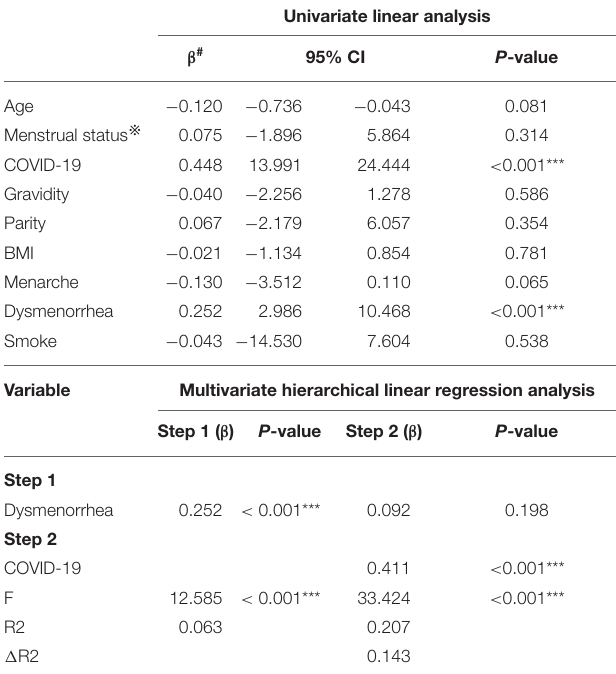
TABLE 4 | Linear regression for association of COVID-19 disease with sex hormone PRL. Univariate linear analysis